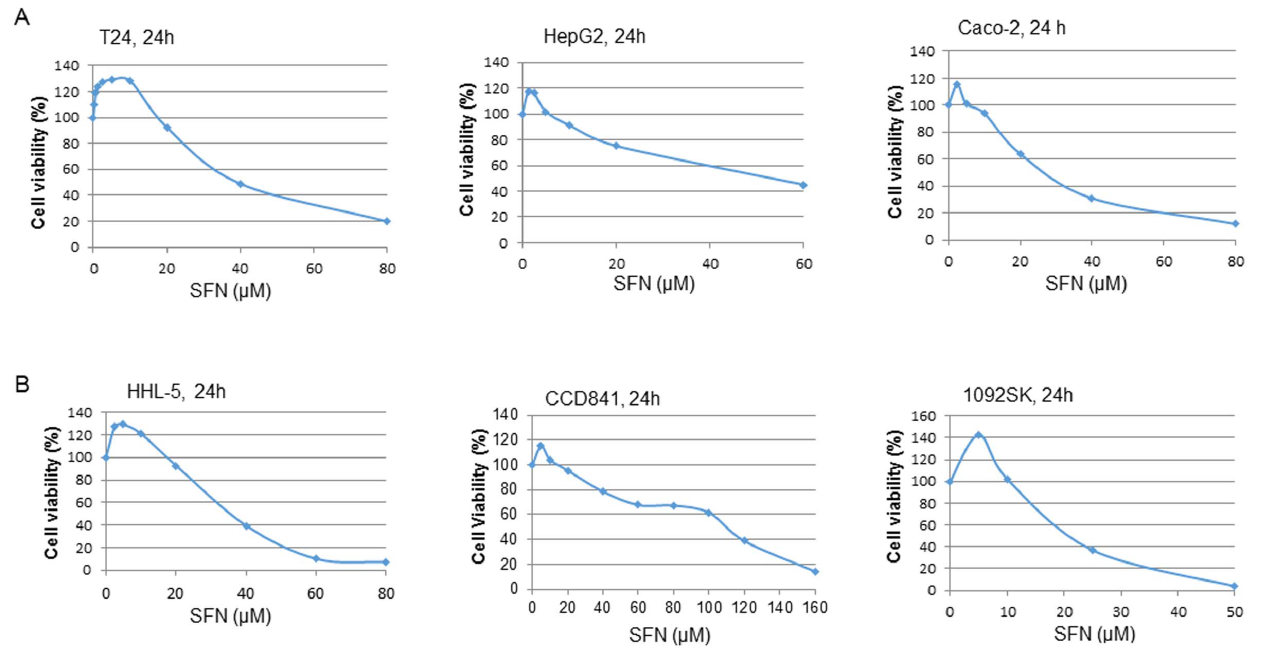
Fig. 1. Effects of SFN on the proliferation of normal and tumour cells. When cells grew to 70–80% confluence, a range of doses of SFN (0–160 m M) were added to the cell culture medium for 24–48 h. The control cells were treated with DMSO (0.1%), and cell viability was determined by the MTT cell proliferation assay (CCD-1092SK cell viability was determined by WST-1 assay according to manufacturer’s instructions [88]). Each data point represents the mean ¡ SD of at least 5 replicates. Statistical significance from the control, *p , 0.05, or **p , 0.01. A: results from bladder cancer T24, hepatoma HepG2, and colon cancer Caco-2 cells. B: Results from immortalised hepatocyte HHL-5, colon epithelial CCD841, and skin fibroblast CCD-1092SK cell lines.